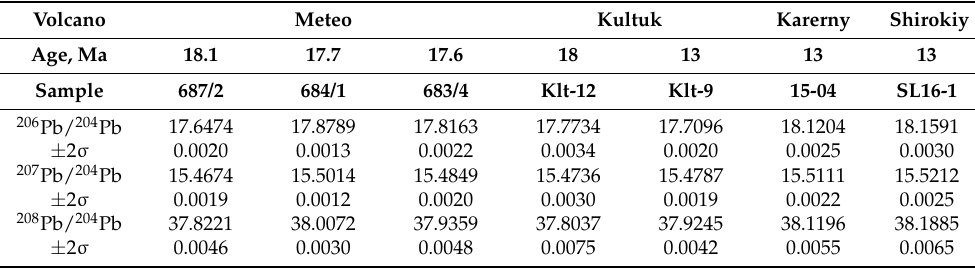
Table 2. Cont. Volcano Compared with volcanic rocks (Table 2), basic pseudotachylytes have a lower MgO content. Since abundance of this oxide in a melt is functionally dependent on tempera- ture [78–80], the MSF pseudotachylyte melts had obviously lower temperatures than those of the KSZHT. On a MgO–SiO 2 diagram (Figure 9a), data points of pseudotachylyte samples KL-22 and KL-9 with the highest MgO content are plotted close to volcanic rocks with the lowest content of this oxide. Consequently, temperatures of melts quenched into pseudotachylytes KL-22 and KL-9 were comparable with minimal temperatures of erupted basaltic melts. Low-Ti pseudotachylyte KL-22 shows a lower SiO 2 content than moderate-Ti pseudotachylyte KL-9. Other low- and moderate-Ti pseudotachylytes show intersecting trends of increasing SiO 2 and decreasing MgO abundances